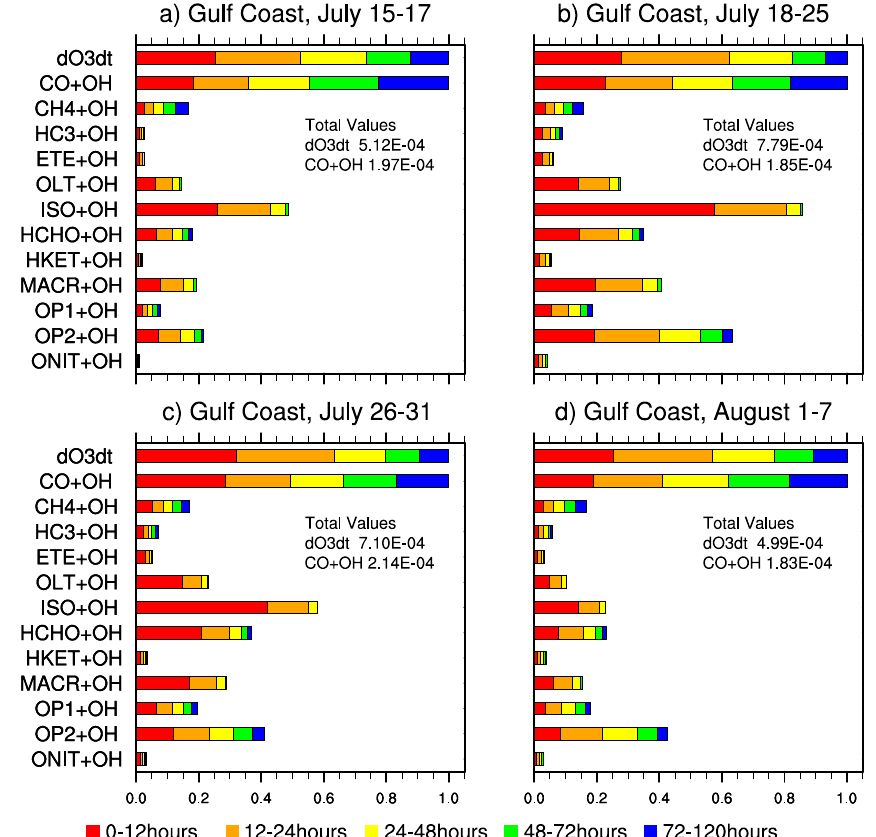
Fig. 12. The same as Fig. 11 but for the Gulf Coast region, which is shown in Fig.